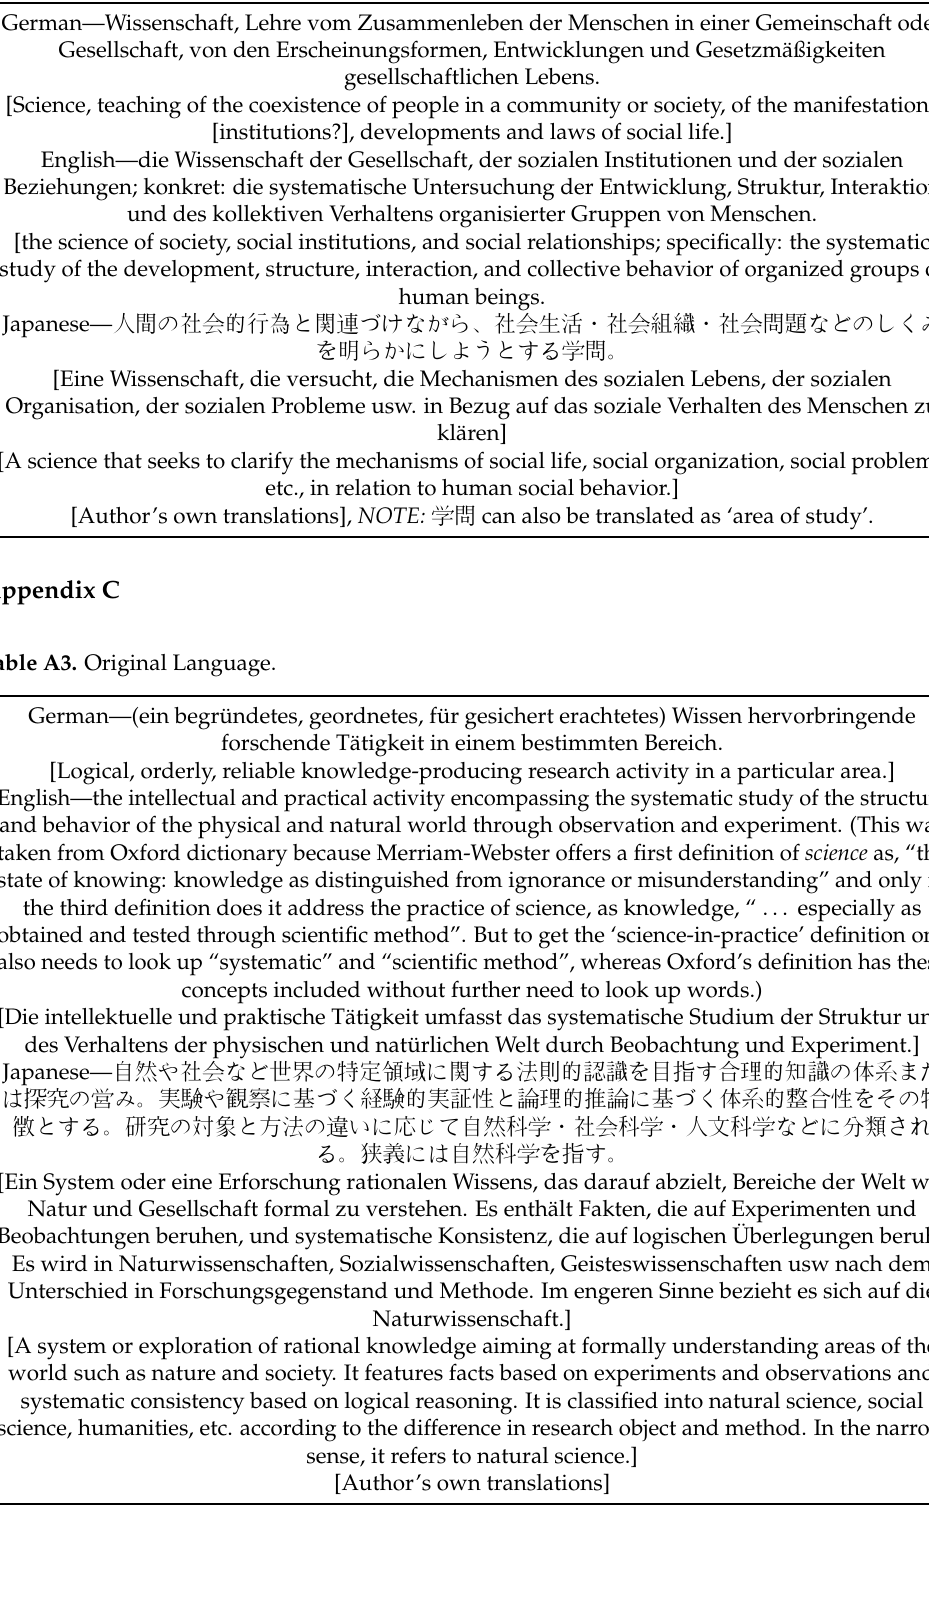
Table A2. Original Language.